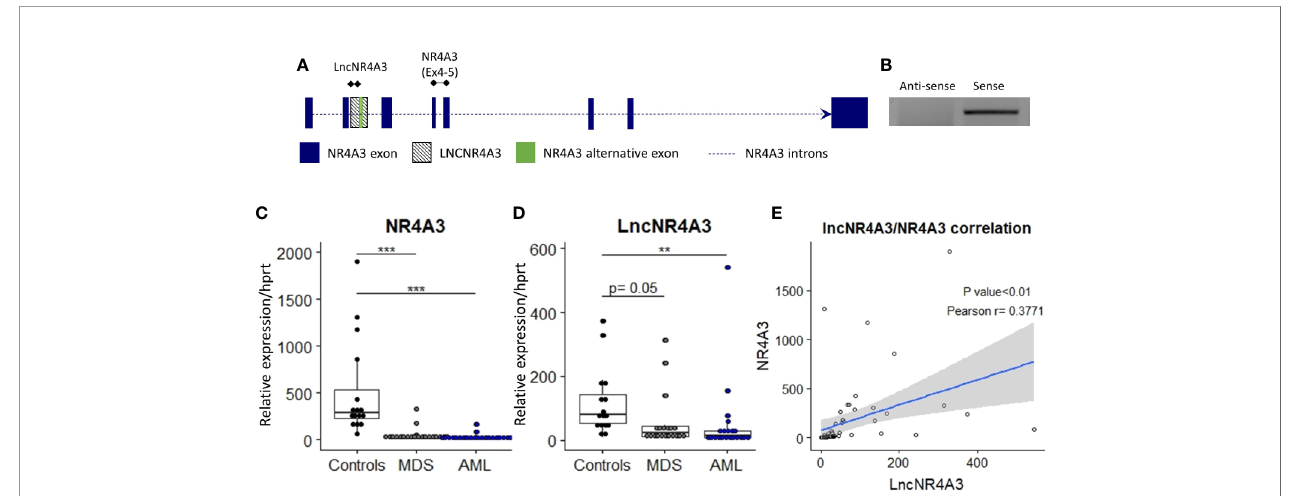
FIGURE 1 | (A) Transcriptional map of the NR4A3 locus showing position of LncNR4A3 and primers used in this work. (B) EtdBr-staining bands in agarose gel electrophoresis from strand-speci fi c PCR to identify the orientation of the transcript, lncNR4A3 is transcribed in the same orientation than NR4A3. (C, D) Quantitative RT-PCR (QRT-PCR) quanti fi cation of NR4A3 and long non-coding transcript, LncNR4A3, in normal bone marrow cells (NBM) of 15 controls, 20 myelodysplastic syndrome patients (MDS), and 21 acute myeloid leukemia patients bone marrows (AML). (E) Linear regression of the expression of LncNR4A3 plotted against NR4A3 expression and correlation analysis results (Pearson correlation P value, R coef fi cient). ** : <0.01, *** :